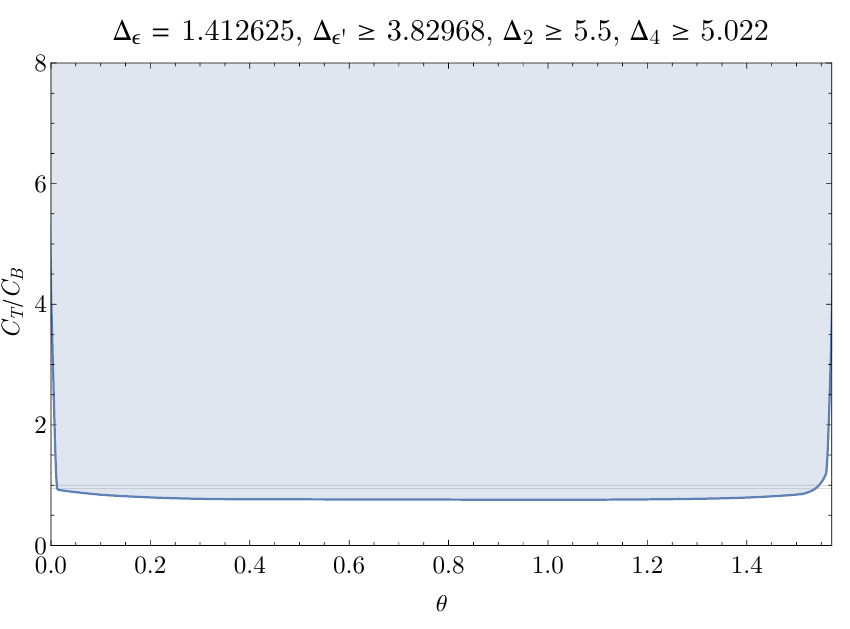
Figure 14 . Lower bound on C T as a function of (cid:18) assuming known low-lying gaps in the parity-even spectrum in the 3d Ising